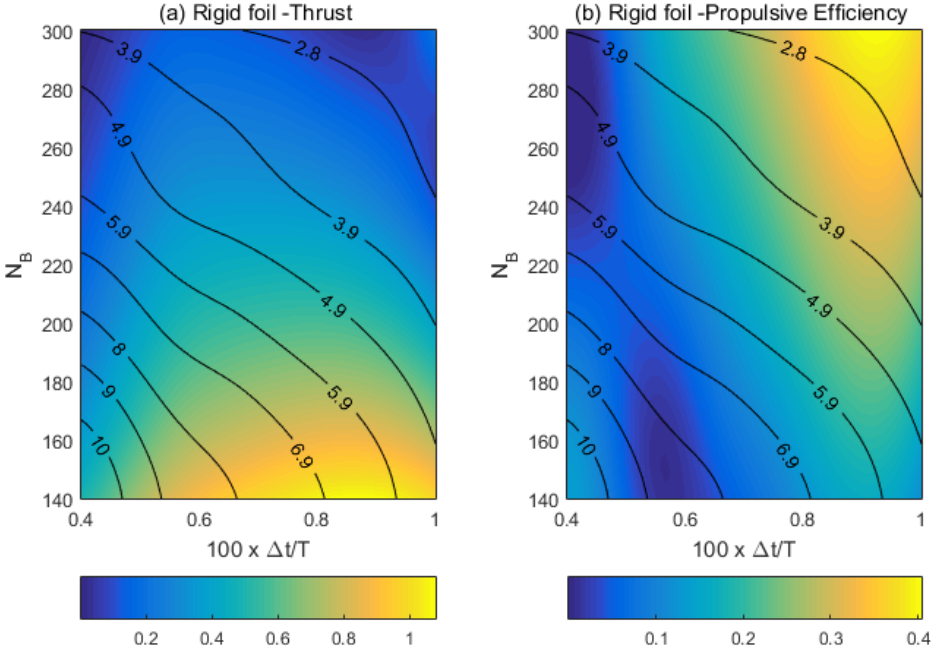
Figure 7. Relative error (%) of ( a ) the thrust e ffi ciency coe ffi cient C T (left) and ( b ) the propulsive e ffi ciency η F (right) with respect to the value of the finest discretization simulated with BEM–NR. The error is denoted by the color-bar, and the contours display the iso- λ values. For the following kinematic parameters h o / c = 0.75, α ef f = 22 ◦ , Str = 0.3, x R = x LE , ψ = − 90 ◦